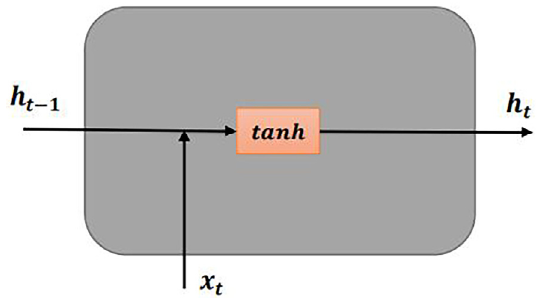
Figure 1. The structure of Simple Recurrent Neural Network (RNN) cell.